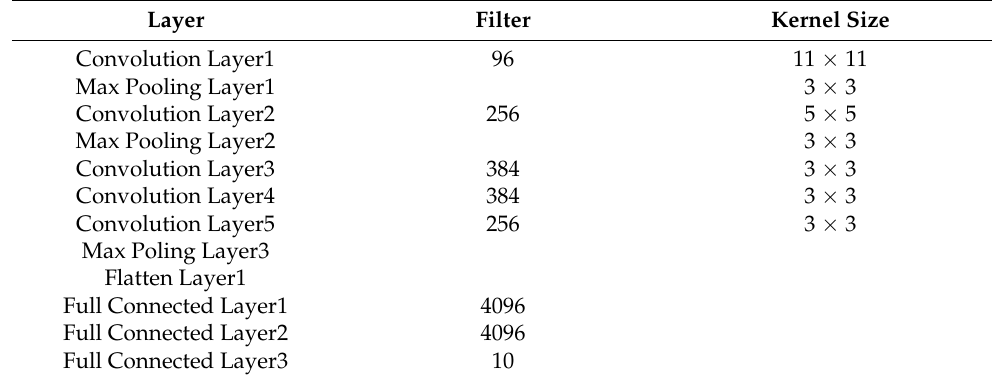
Table 1. Parameter settings of AlexNet.